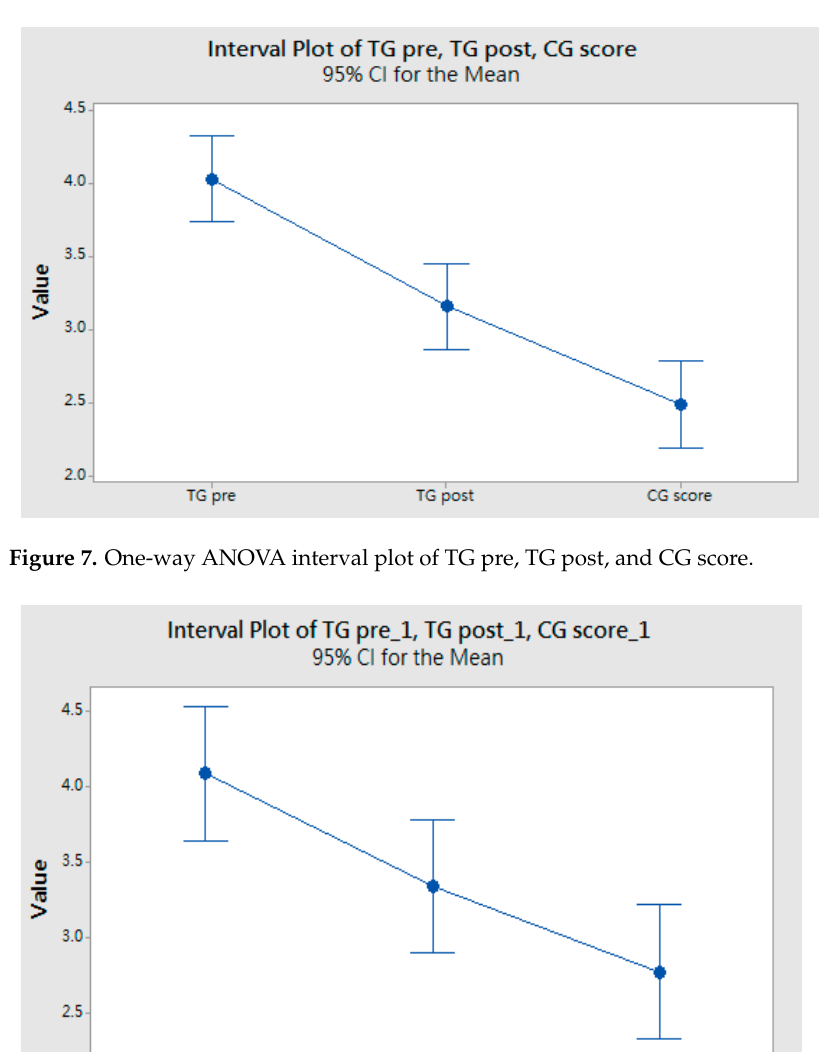
Figure 7. One-way ANOVA interval plot of TG pre, TG post, and CG score.